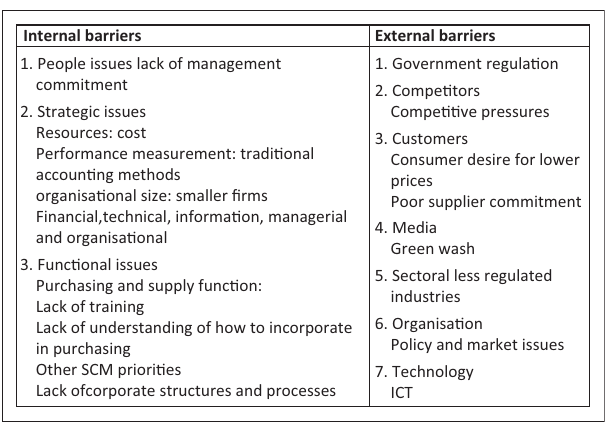
FIG URE 1: Drivers towards sustainable practices.